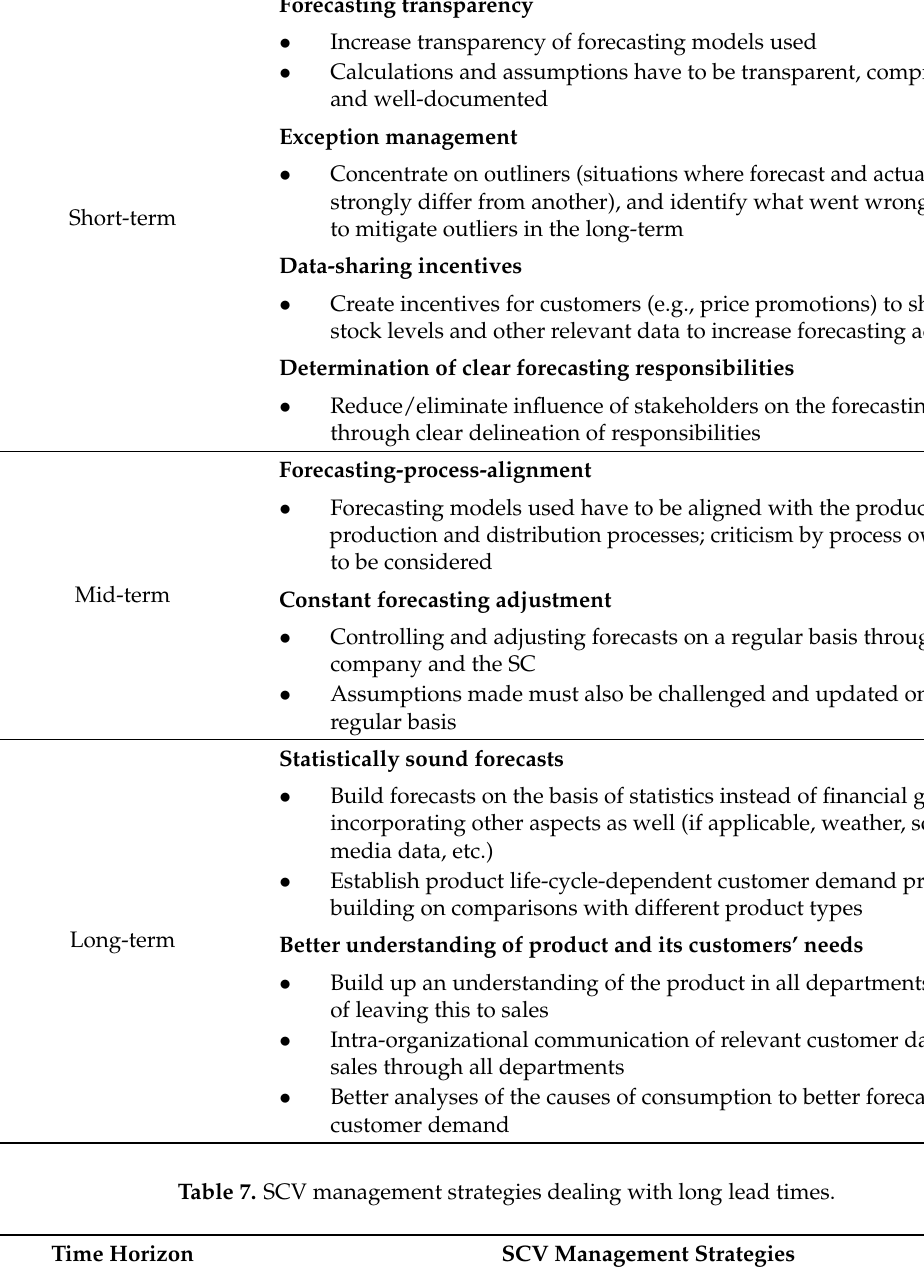
Table 6. SCV management strategies dealing with inaccurate forecasting. Time Horizon